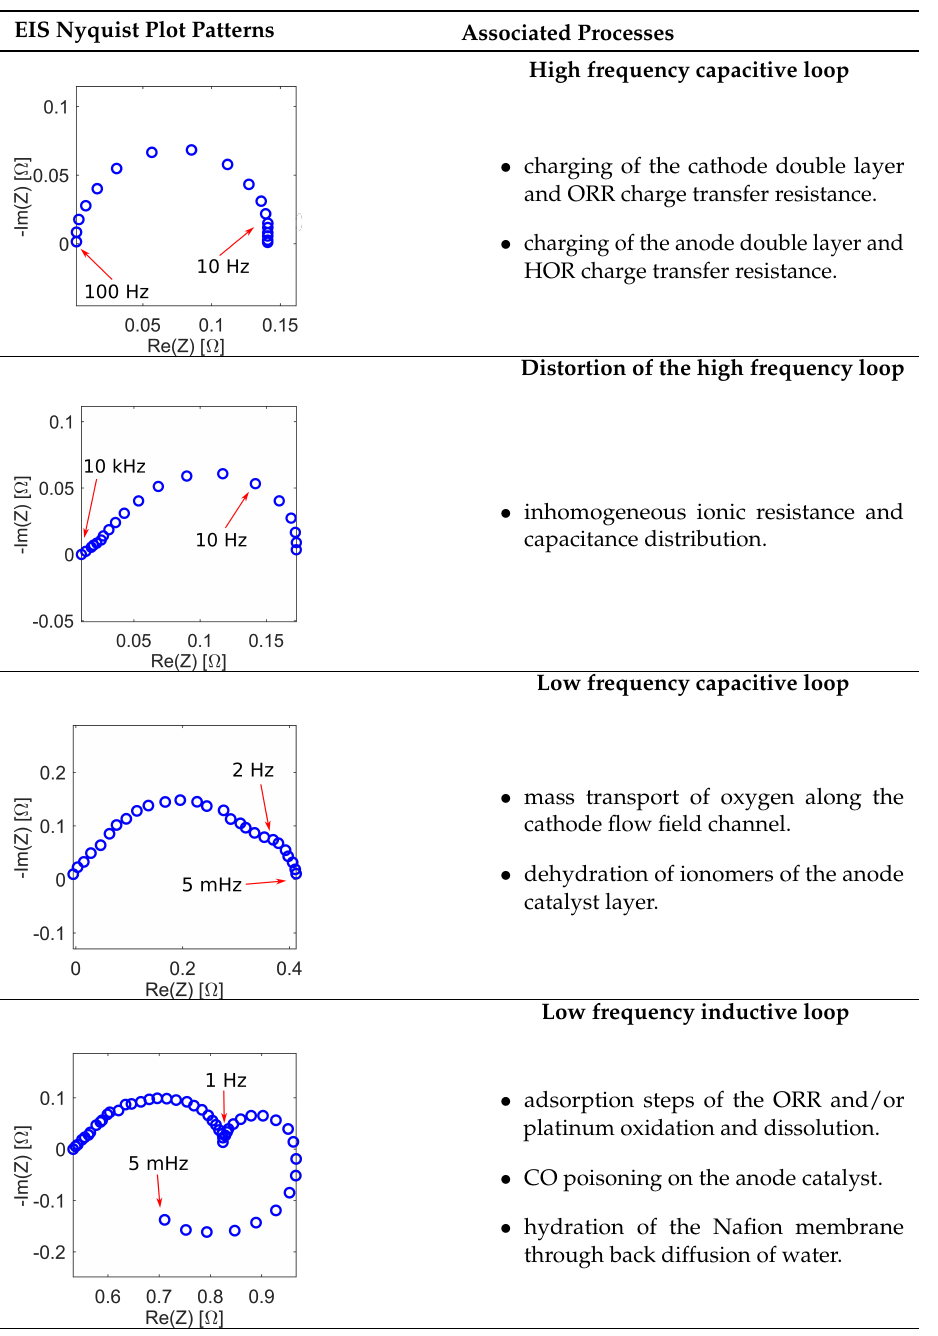
Table 1. Most common pattern of EIS Nyquist plot related to polymer electrolyte membrane fuel cells (PEMFCs). The figures are respectively adapted from Springer et al. [64], Paganin et al. [66], Ciurenau et al. [67], and Wiezell et al.